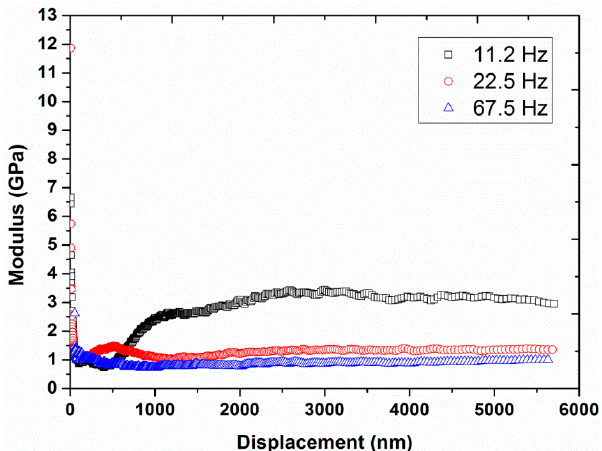
Figure 6. Modulus as a function of displacement for the three different frequencies (11.2, 22.5, and 67.5 Hz) at a vibration amplitude of 2 nm and strain rate of 0.05 s − 1 .